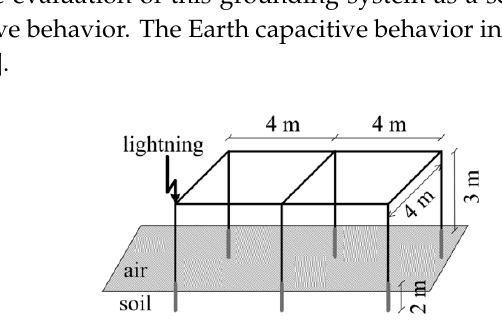
) g . e D ( e g l n A e s a h P